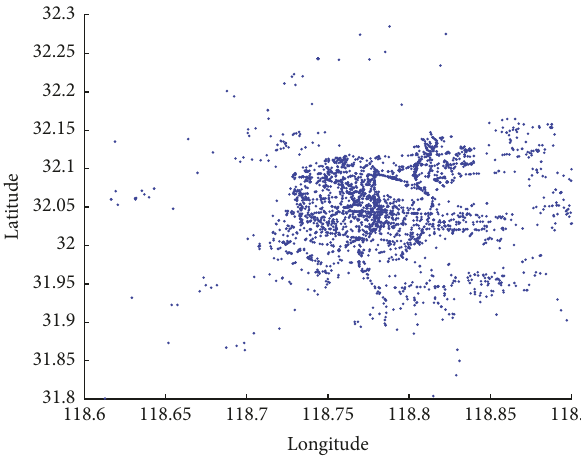
Figure 2: Passenger taxi to get-off point scatter diagram in Nanjing City between 9:00 and